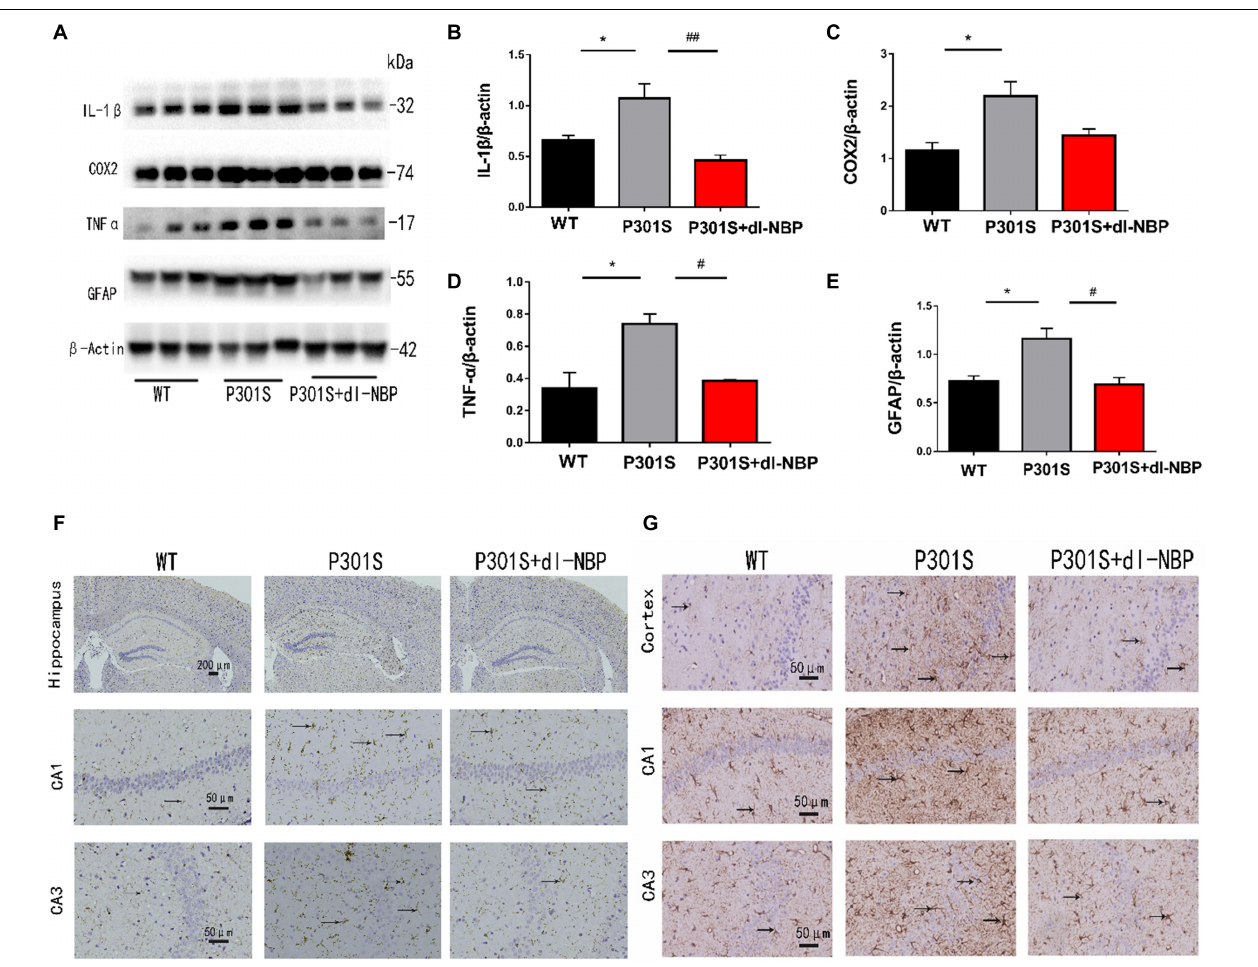
FIGURE 5 | dl-NBP treatment inhibited inflammation in P301S mice. (A) Western blotting of GFAP, IL-1 β , TNF α , and cox2. (B–E) Quantitative analyses of western blot for GFAP, IL-1 β , TNF α , and COX2. β -Actin was used as an internal control. (F) Immunohistochemical staining with CD11b antibody and the GFAP antibody in the brains of the three groups of mice. Scale bars: upper panel—200 µ m, lower two panels—50 µ m. (G) Immunohistochemical staining GFAP antibody in the brains of three groups of mice. Scale bar: 50 µ m. All results were presented as mean ± SEM ( n = 4). * P < 0.05, WT mice vs. P301S mice; # P < 0.05, ## P < 0.01, P301S mice vs. P301S + dl-NBP